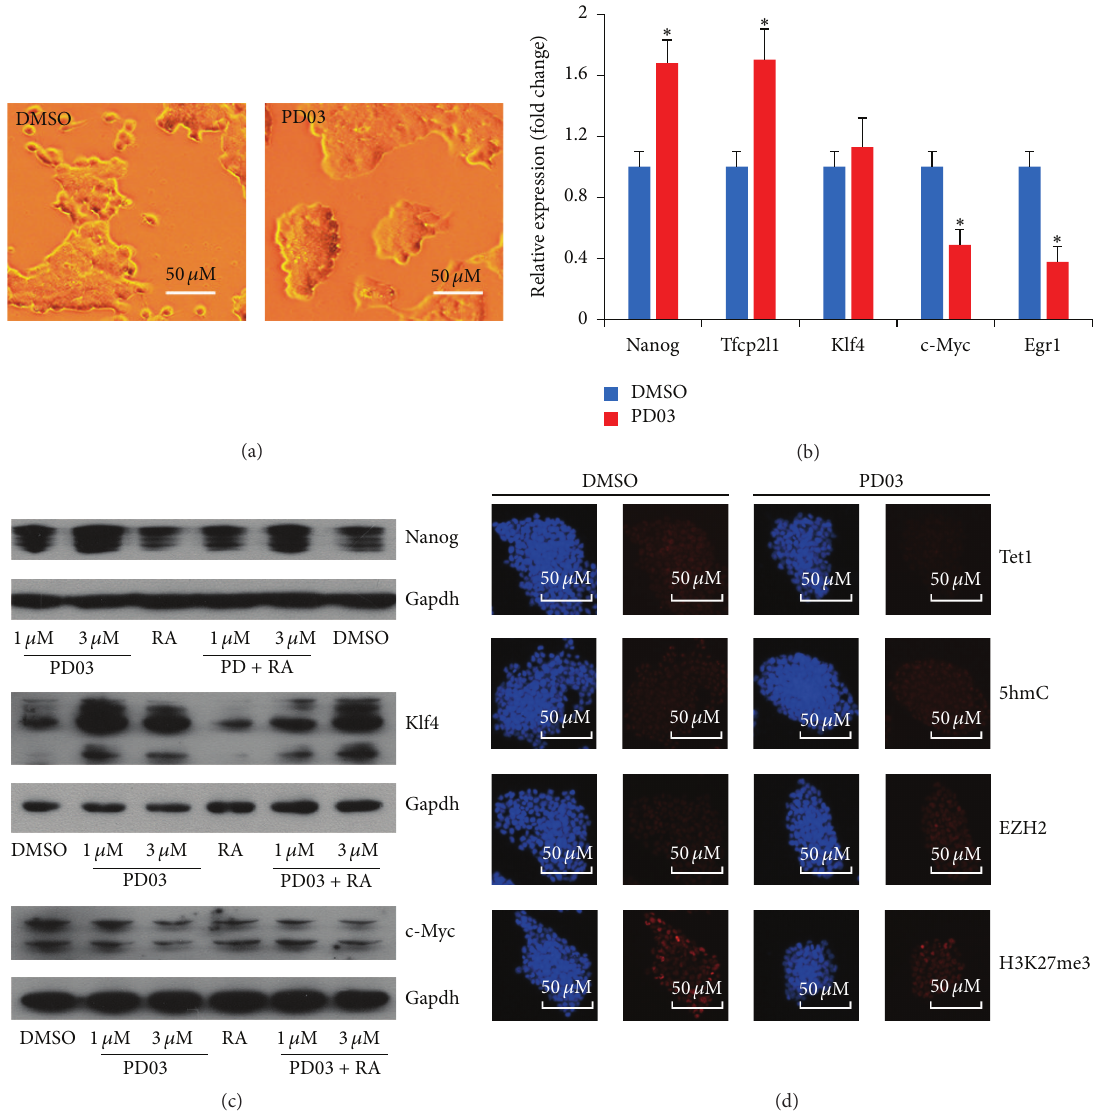
Figure 1: Suppression of MEK/ERK signaling promotes self-renewal and colony morphology of mESCs. (a) PD promotes colony morphology ofmESCs.J1mESCsweretreated with 1 𝜇 MPDorequal volume ofDMSO for24 h.Morphological changes wereobserved and recorded under a phase contrast microscope. Scale bar = 50 𝜇 m. (b) PD influences the expression pluripotent factors. ESCs were treated with or without 1 𝜇 M PD for 24h; then the expression levels of Nanog , Tfcp2l1 , Klf4 , c- Myc , and Egr1 were analyzed by RT-qPCR. Gapdh was used as a normalization control. Error bars indicate mean ± SD of three independent experiments, ∗ 𝑝 < 0.05 compared with controls. (c) PD antagonizes RA-induced differentiation of ESCs. ESCs were treated with the indicated concentration of PD and/or together with 1 𝜇 M RA for 24 h; equal volume of DMSOwasaddedforcontrolsamples.ThentheproteinexpressionlevelsofNanog,Klf4,andc-Mycwereanalyzedbywesternblot.Gapdhwas used as a normalization control. (d) PD do not influence epigenetic regulation of ESCs. ESCs were treated with the 1 𝜇 M PD or equal volume of DMSO for 24 h. Immunofluorescence staining assay was used for analysis of the expression level of 5hmC, Tet1, Ezh2, and H3K27me3. Nuclei were stained with DAPI; scale bar = 50 𝜇